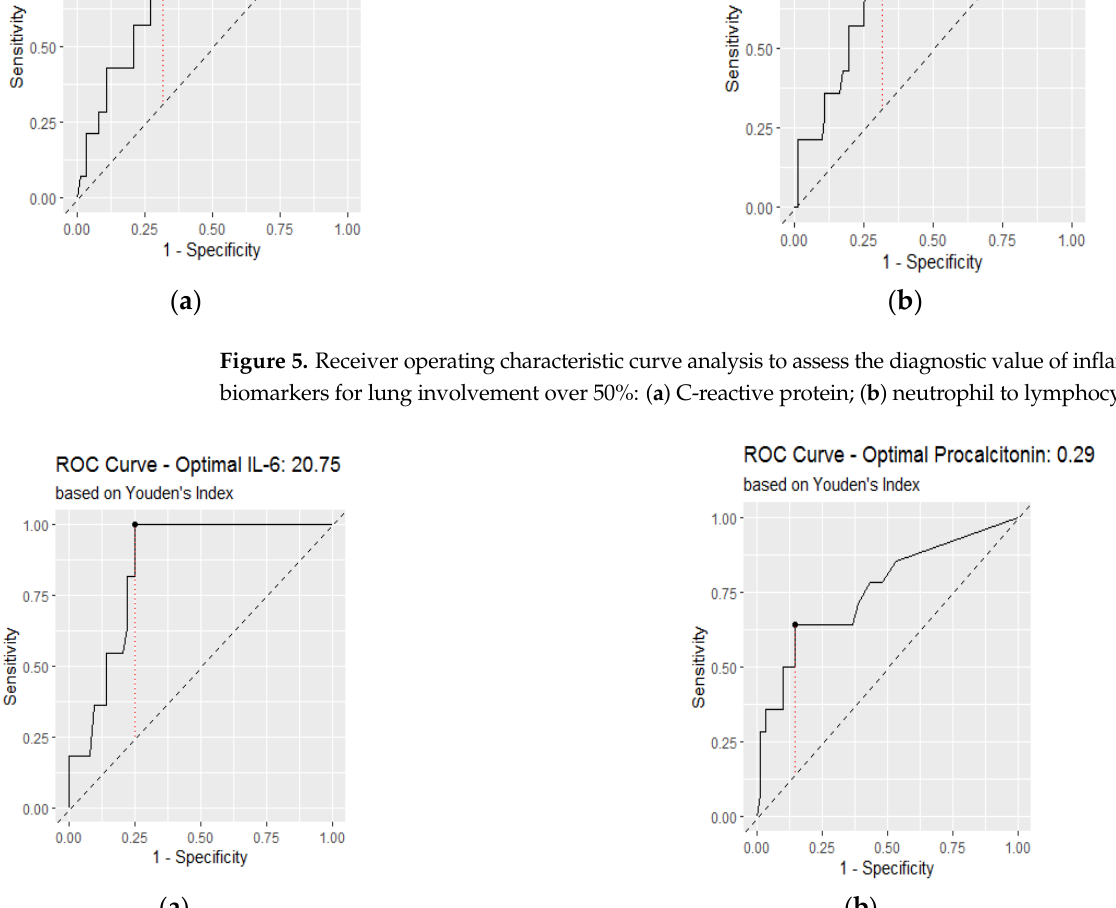
Figure 6. Receiver operating characteristic curve analysis to assess the diagnostic value of inflam ‐ matory biomarkers for lung involvement over 50%: ( a ) interleukin ‐ 6; ( b ) procalcitonin. Table 2. The optimal cut-offs of CRP, NLR, IL-6, and procalcitonin. Biomarker AUC Optimal Cut-Off Youden Sensitivity